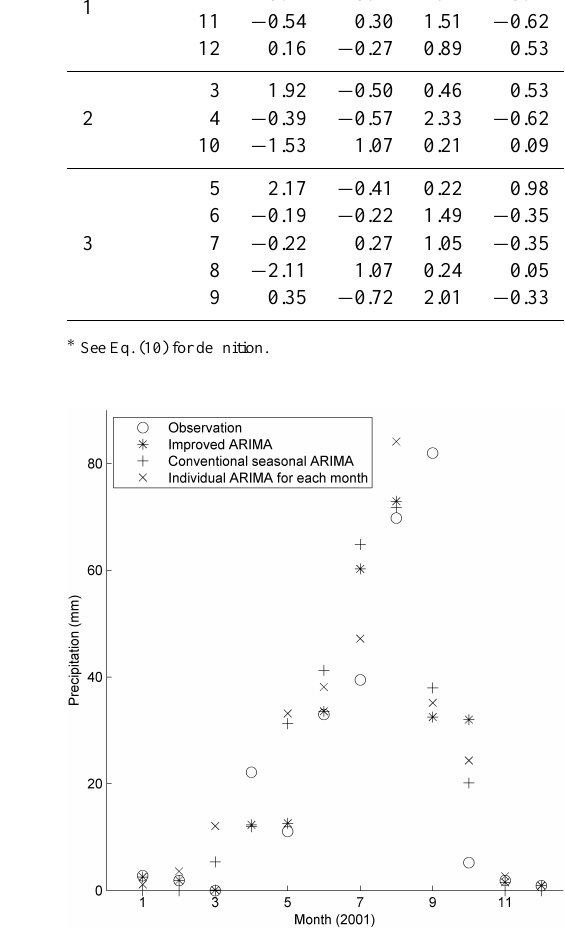
Figure 9. Comparison between predictions and observation.